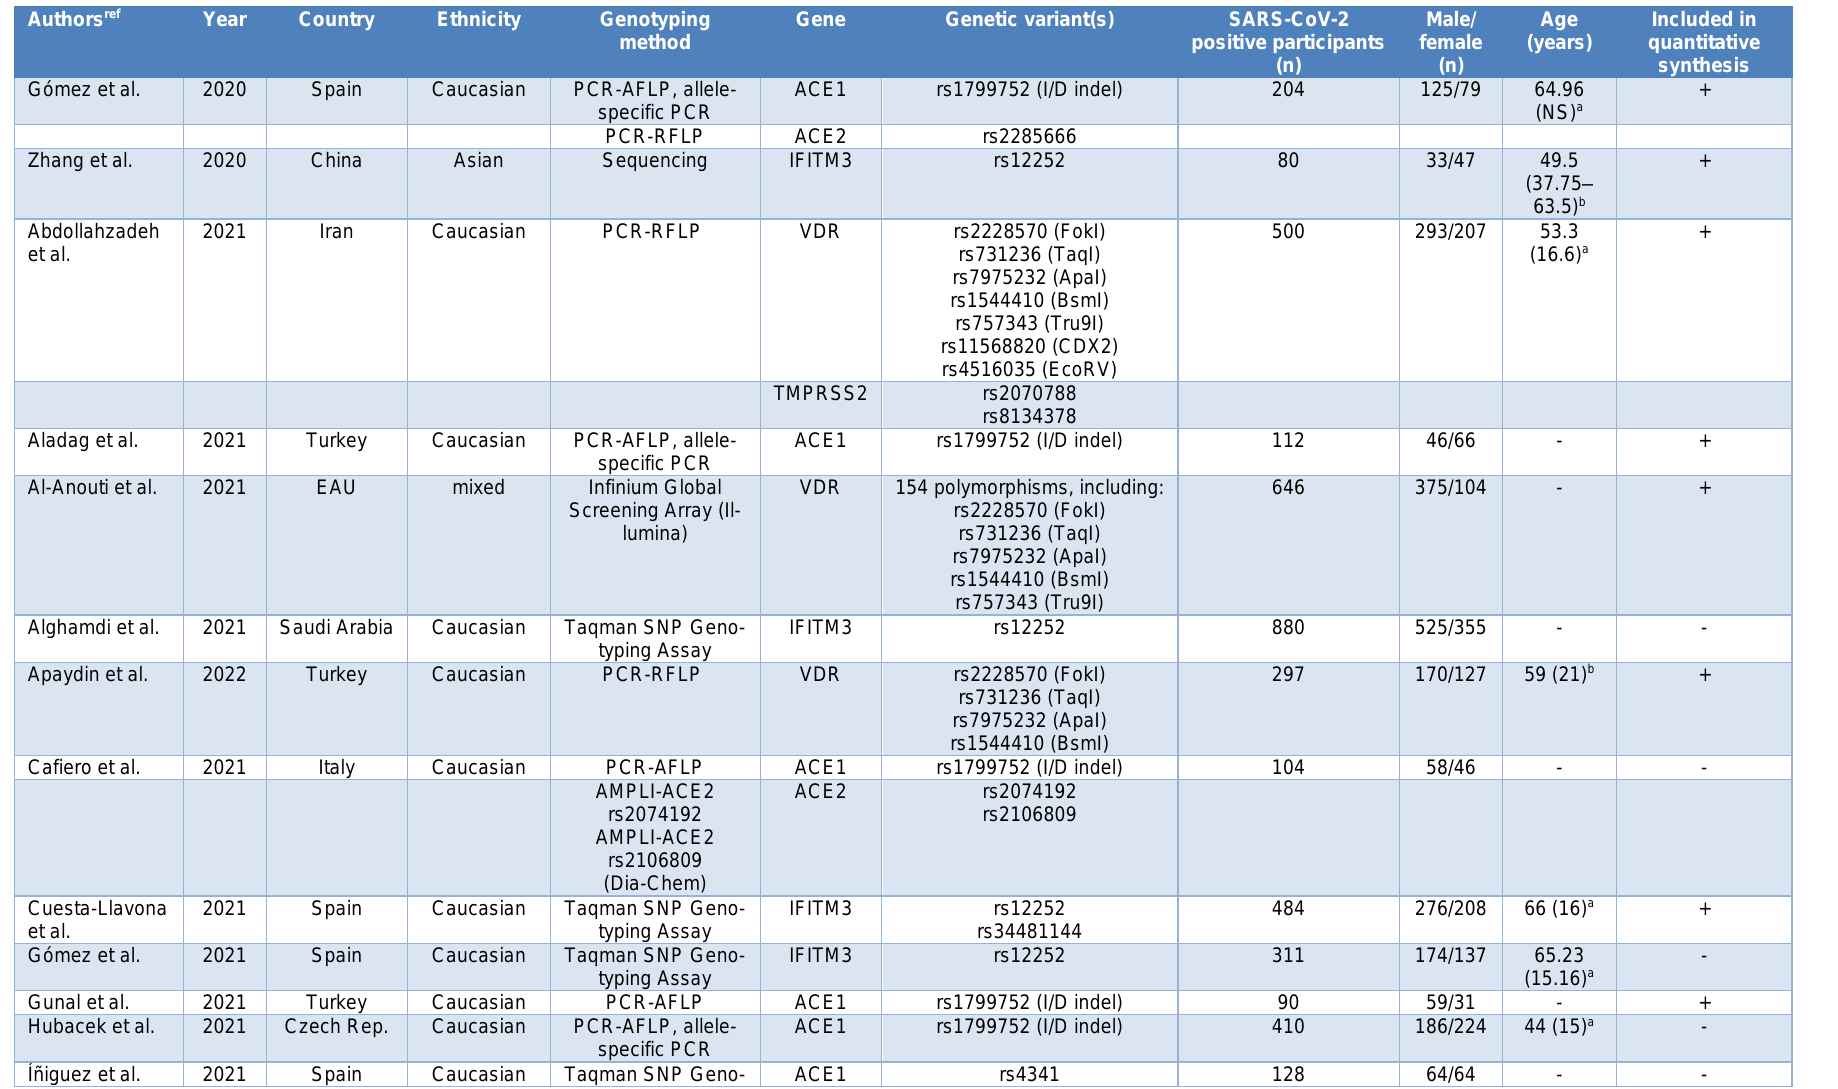
Table 1: Characteristics of the studies included in the qualitative synthesis Authors